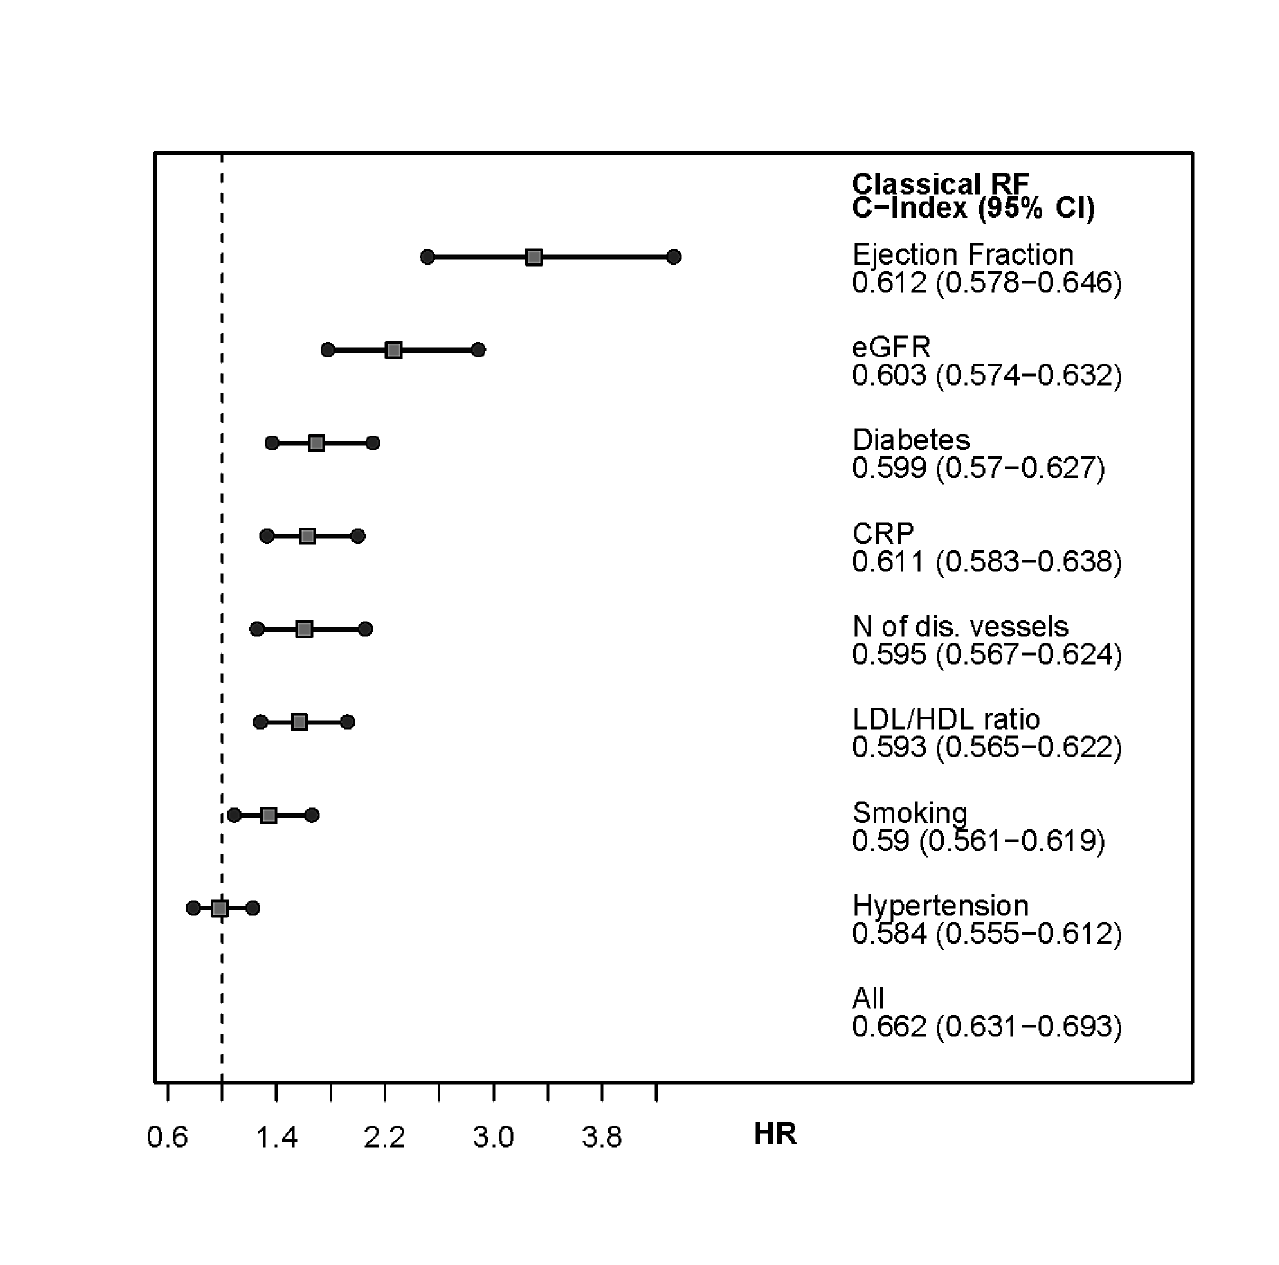
Fig 1. Hazard Ratio and C-Index for investigated risk factors (adjusted for age and sex) in the overall cohort. The hazard ratio and the C-Index are for the comparison cardiovascular event vs. no event during follow-up. In these figures creatinine clearance is represented by eGFR.